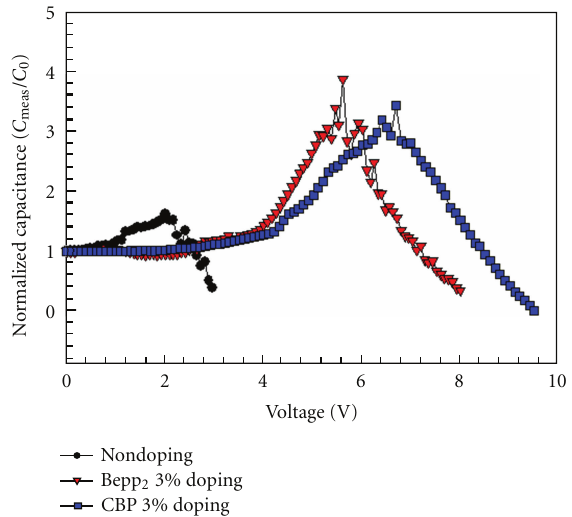
Figure 7: Capacitance variation normalized to geometrical capaci- tance ( C 0 ) with the applied dc voltage.